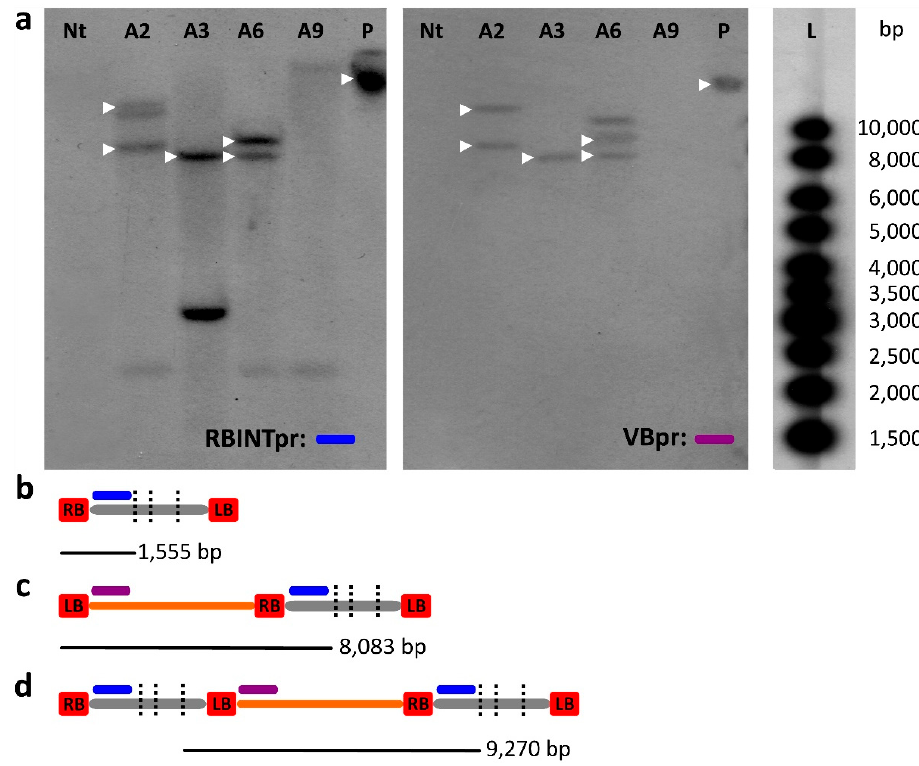
Figure 4. ( a ) Southern hybridization of genomic DNA extracted from T1 A plants with probe RBINTpr (blue segment) or VBpr (purple segment). The bands that hybridized to both probes are marked with a white triangle. Nt: non transgenic; P: binary vector pPZP- hemL - nptII (not linearized); L: 1 Kb ladder; ( b – d ) schemes (not in scale) of the restriction fragments produced by Nco I digestion (black vertical dotted lines are Nco I sites); ( b ) canonical T-DNA processing; ( c ) wrong initiation at the LB and transfer of whole VB along with a single copy of T-DNA; ( d ) correct initiation at the RB and incorrect termination at the LB, resulting in the transfer of the whole VB sequence along with two T-DNA copies. The position of the probes and the length of the restriction fragments are indicated.